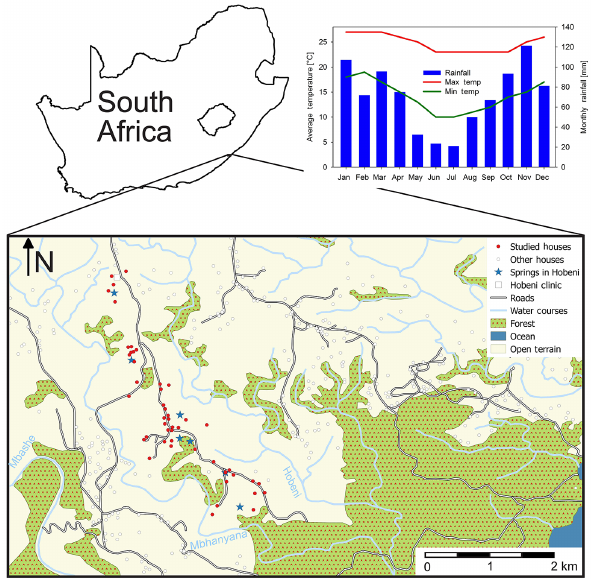
Figure 1. Location map and average